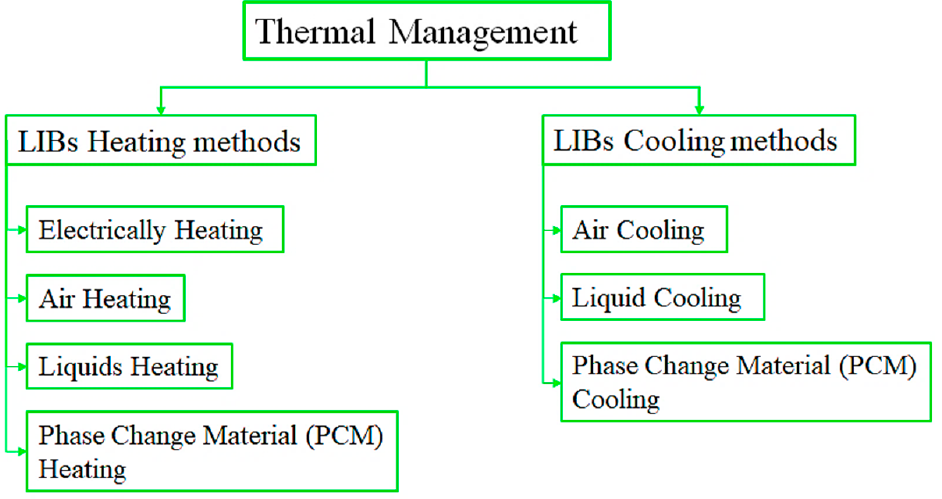
Figure 7. Taxonomy of thermal management system.